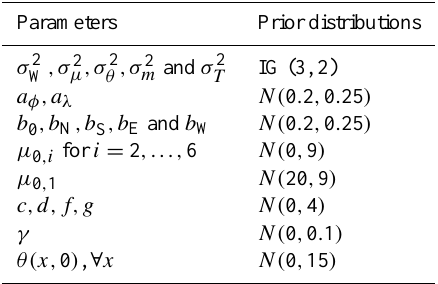
Table 1. Prior distributions for the model parameters. Parameters Prior distributions